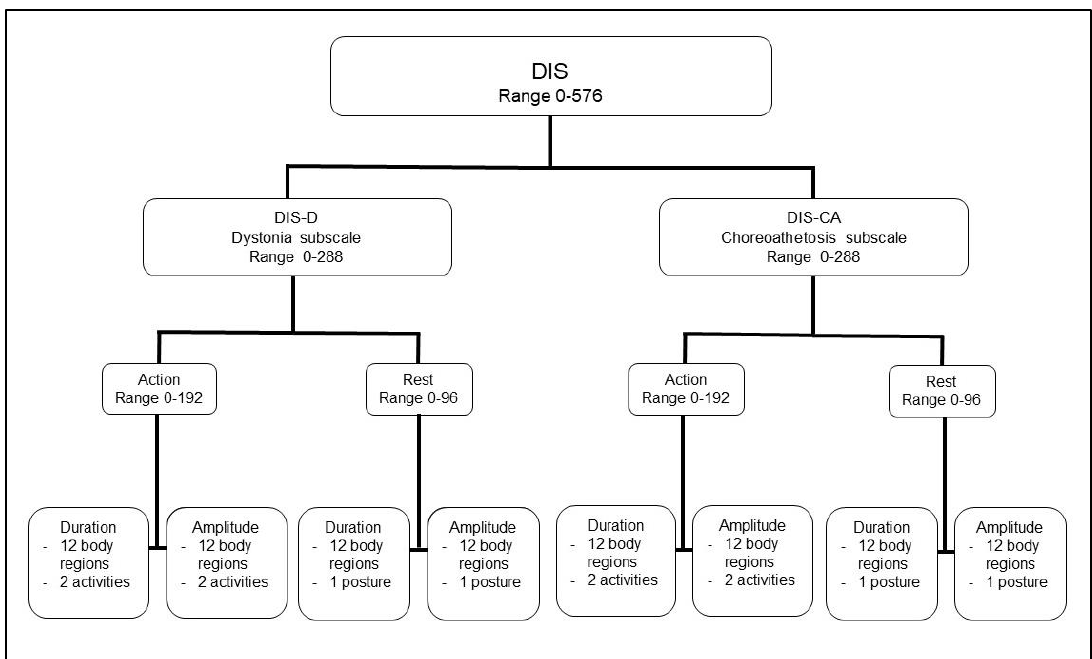
Figure 1. Diagram of the Dyskinesia Impairment Scale (18) .